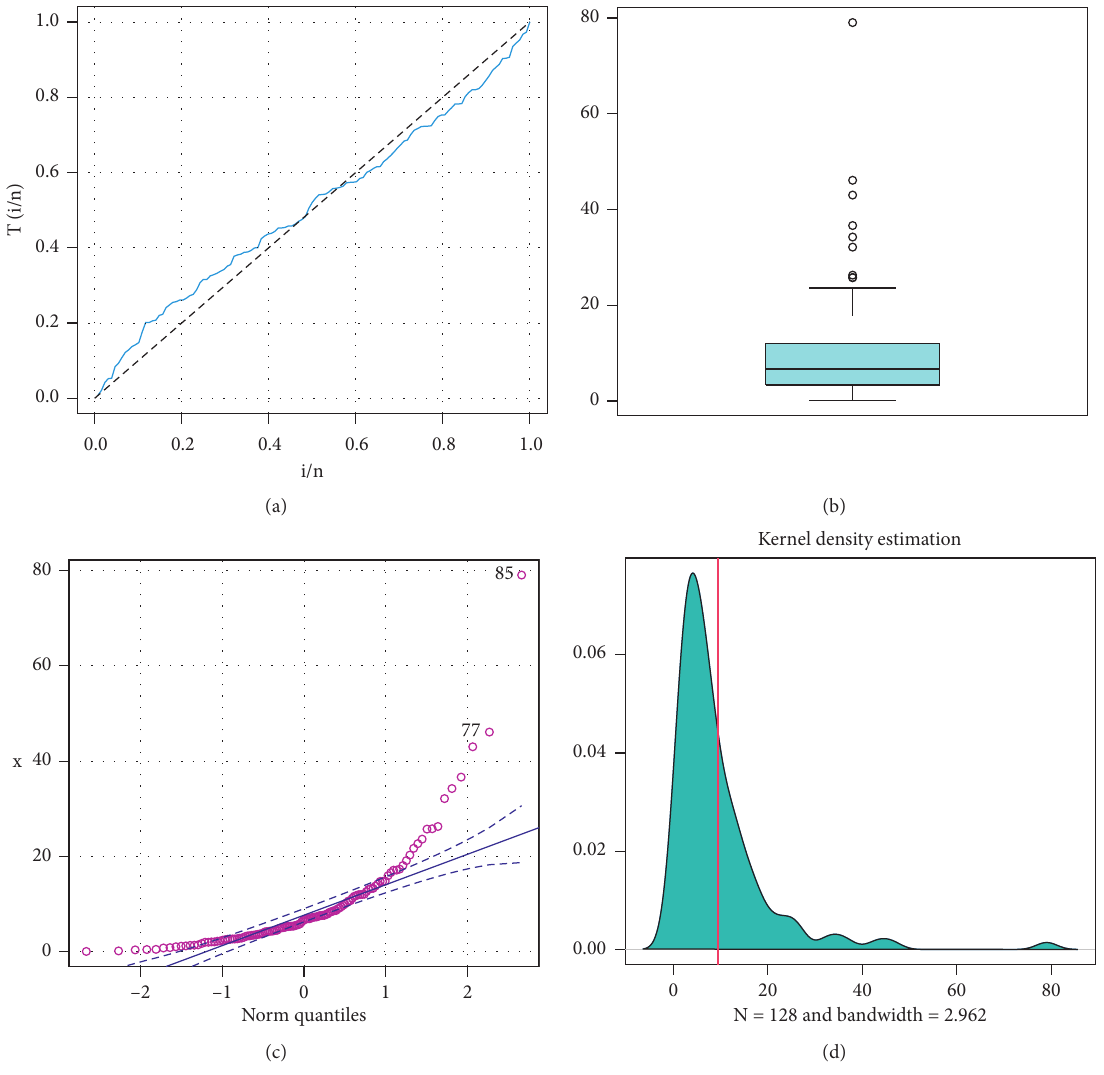
Figure 5: The TTT plot (a), box plot (b), QQ plot (c), and KDE plot (d) for cancer